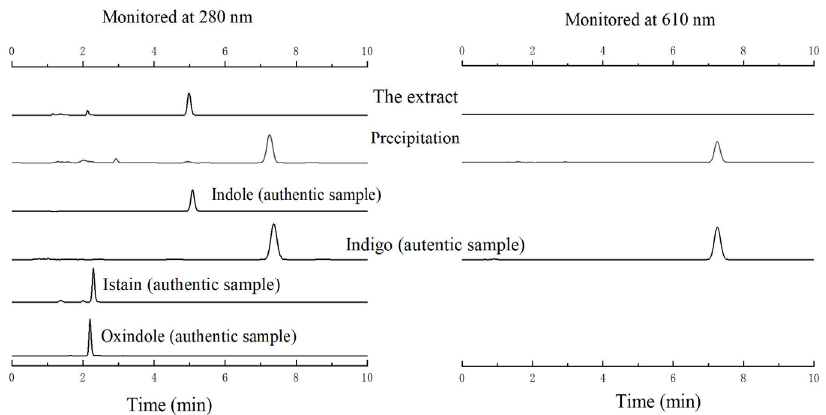
Figure 6. HPLC analysis of the extract of the reaction mixture catalyzed by the F87A P450BM3 mutant monitored at 280 nm ( left ) and 610 nm ( right ). HPLC traces of authentic indole, indigo, isatin, and oxindole samples were shown for comparison.